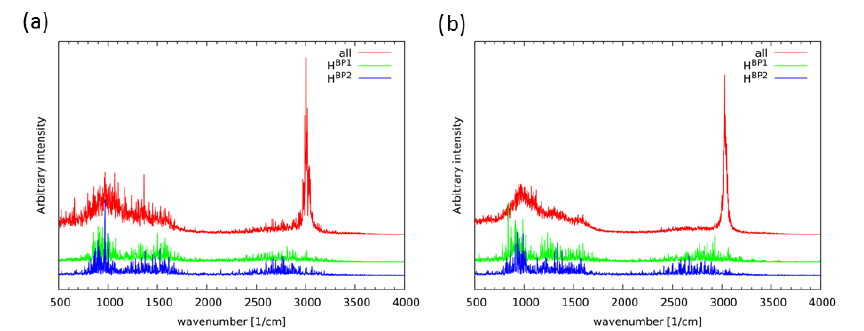
Figure 10. Atomic velocity power spectra resulting from the CPMD simulation at 300K, ( a ) in the gas phase, ( b ) in the solid state. Red line: the all-atom feature, related to the vibrational spectrum, green and blue lines—contributions of the bridge